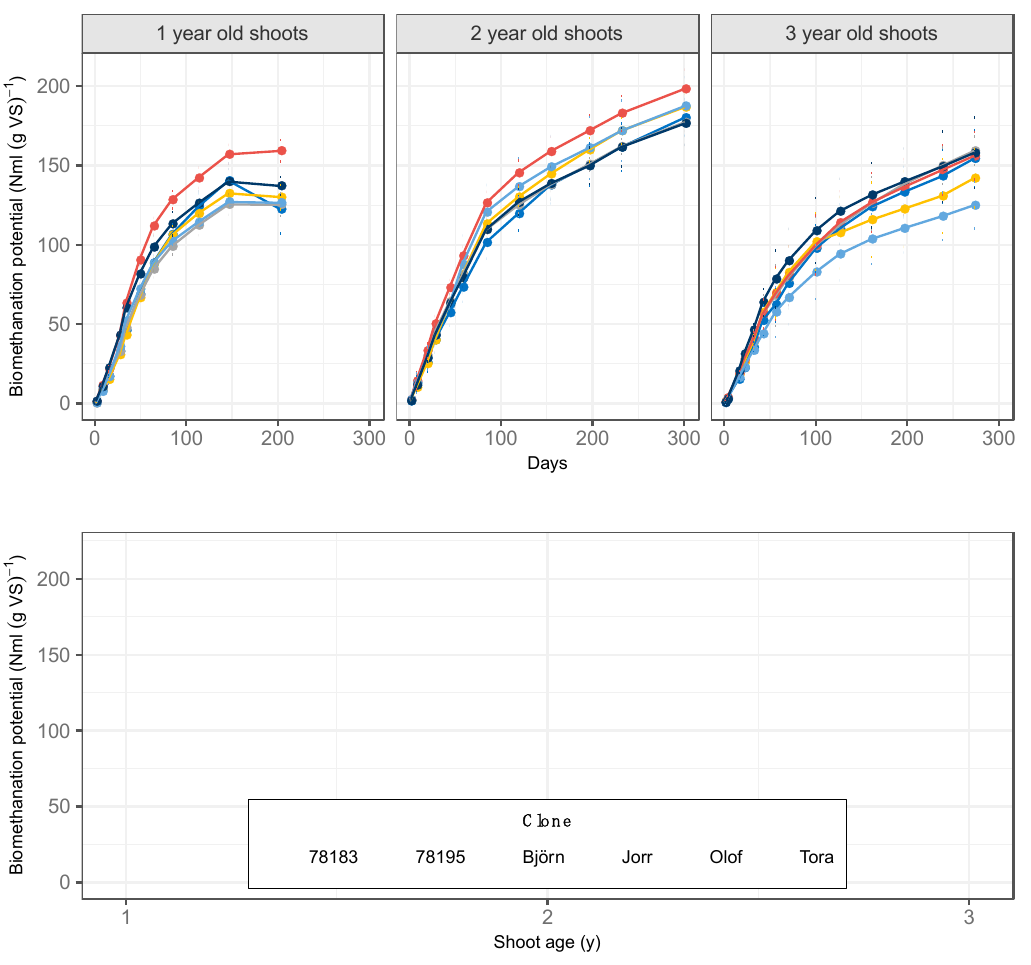
Figure 3. Biomethane production curves of the clones at different shoot ages ( A ), and the biomethanation potential vs. shoot age ( B ). The line in ( B ) illustrates the inverse-U shape of the biomethanation potentials depending on coppicing frequency. VS: volatile solids. Table 1. Biomethanation potentials (Nml (g VS) − 1 ; standard deviation in parentheses) of the Salix clones at different harvest ages.